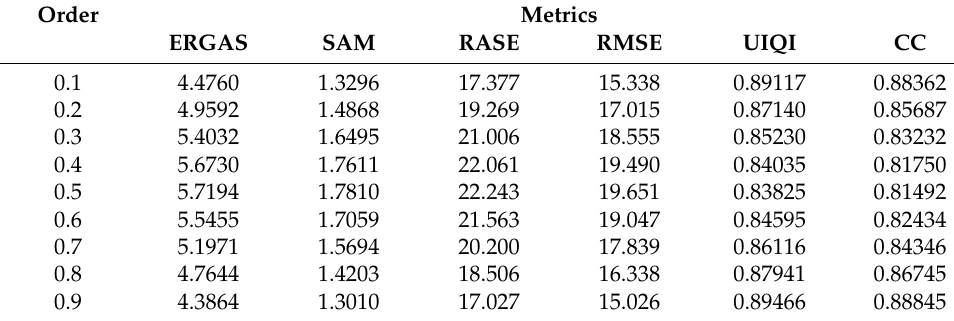
Table 4. Results for computing derivative using a corrected mask.